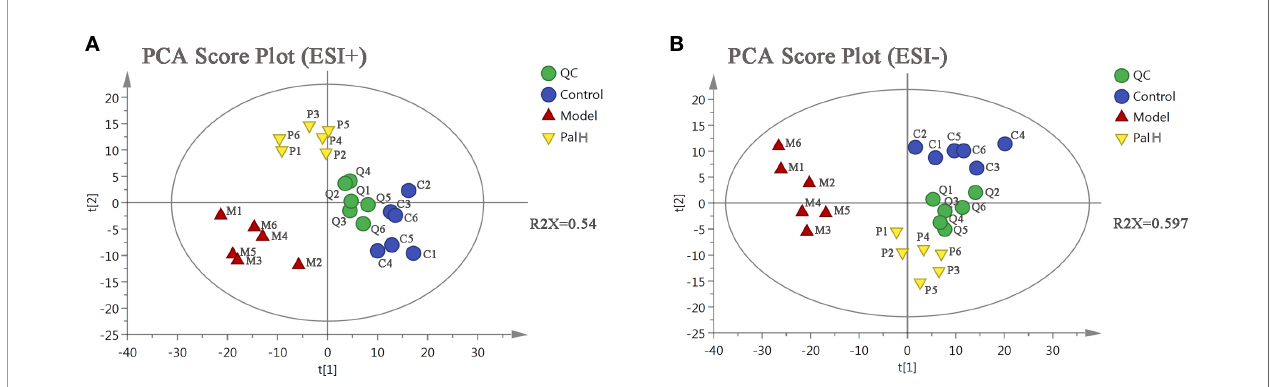
FIGURE 9 | The principal component analysis (PCA) score plot of urine metabolomics analysis. (A) ESI+ model. (B) ESI- model. PalH: (40